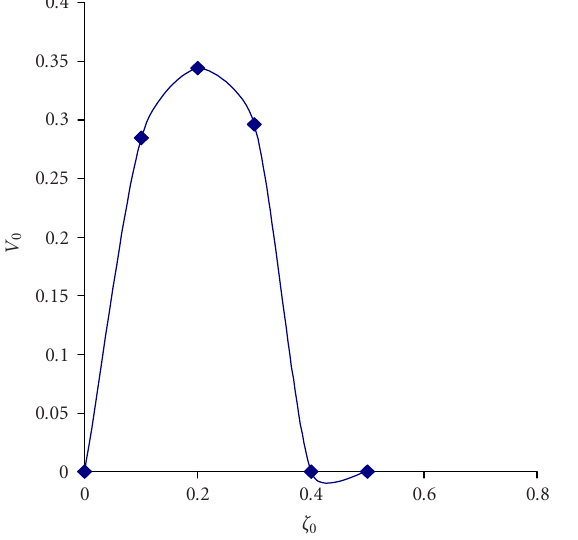
Figure 2.4. ∈= +0 . 1. Variation of velocity of Rayleigh waves with initial stress in viscoelastic medium when λ = 0 and µ = 0 (Figures 2.2, 2.3,